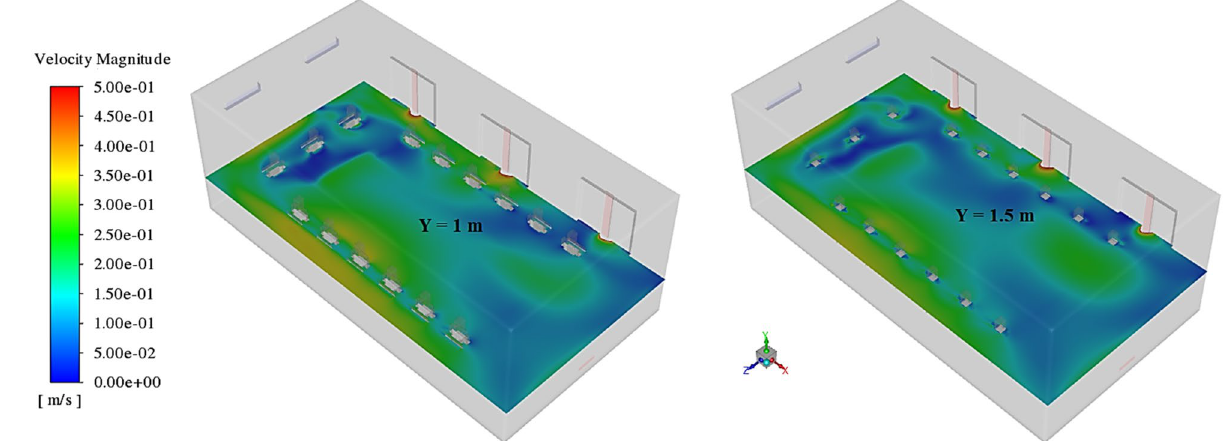
Figure 11. Velocity contours at Y = 1, and 1.5 m, in scenario 1.